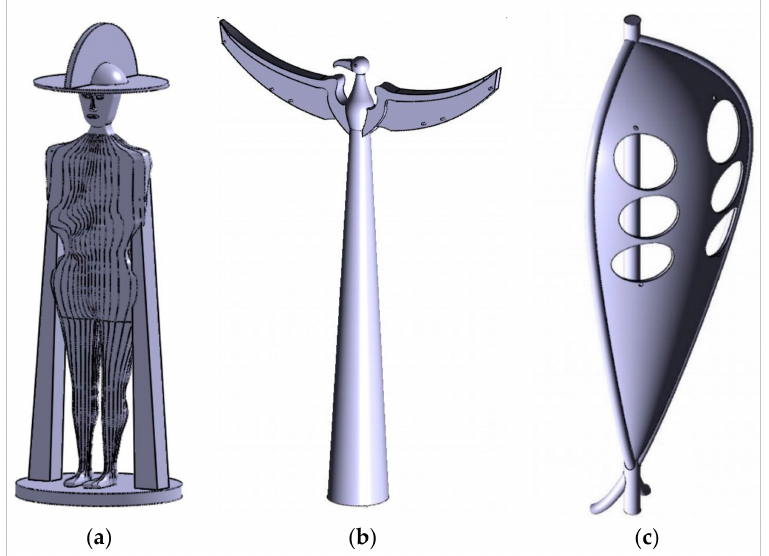
Figure 9. Starting 3D CAD models. ( a ) Capestrano Warrior statue; ( b ) Eagle; ( c ) Sail.